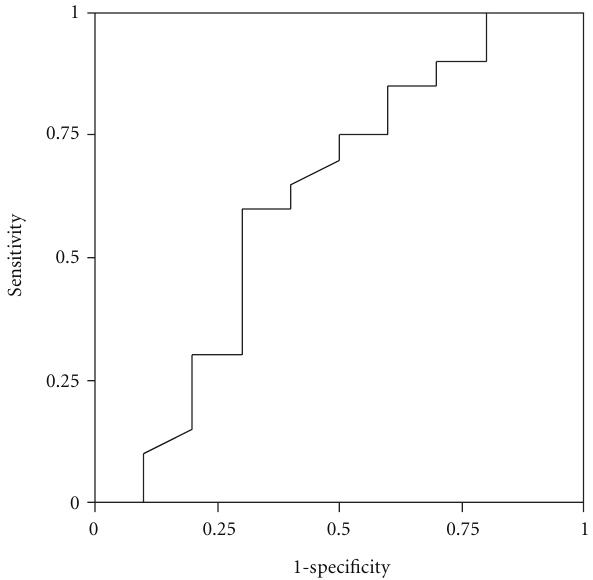
Figure 2: Receiver operating characteristic curve analysis of cumu- lative percent oxidation of methacetin at 40 minutes in patients with and without fibrosis (i.e., noncirrhotic).